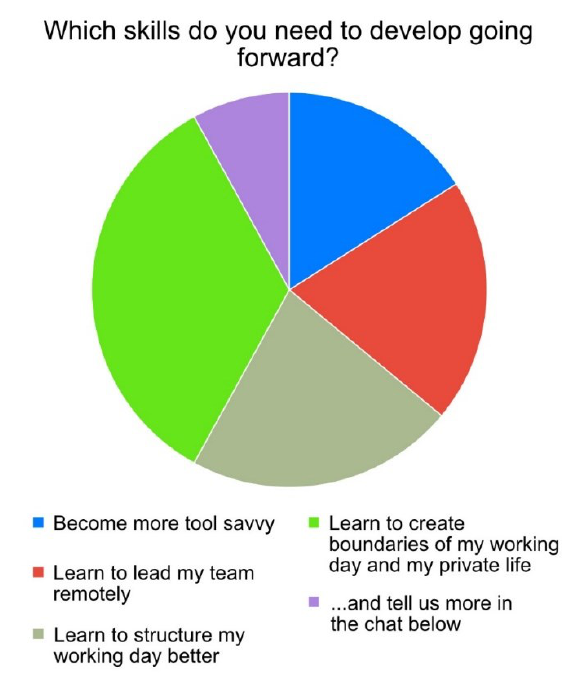
FIGURE 3. WHICH SKILLS DO YOU NEED TO DEVELOP GOING